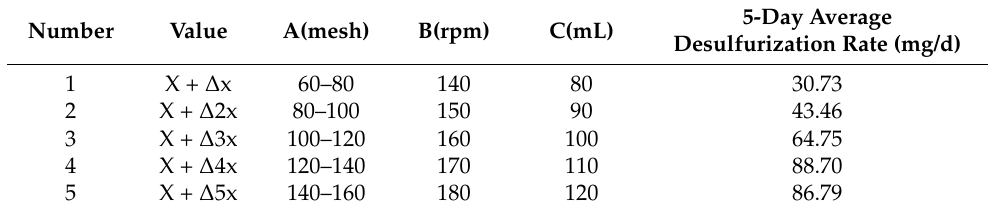
Table 7. Results of the steepest-climb